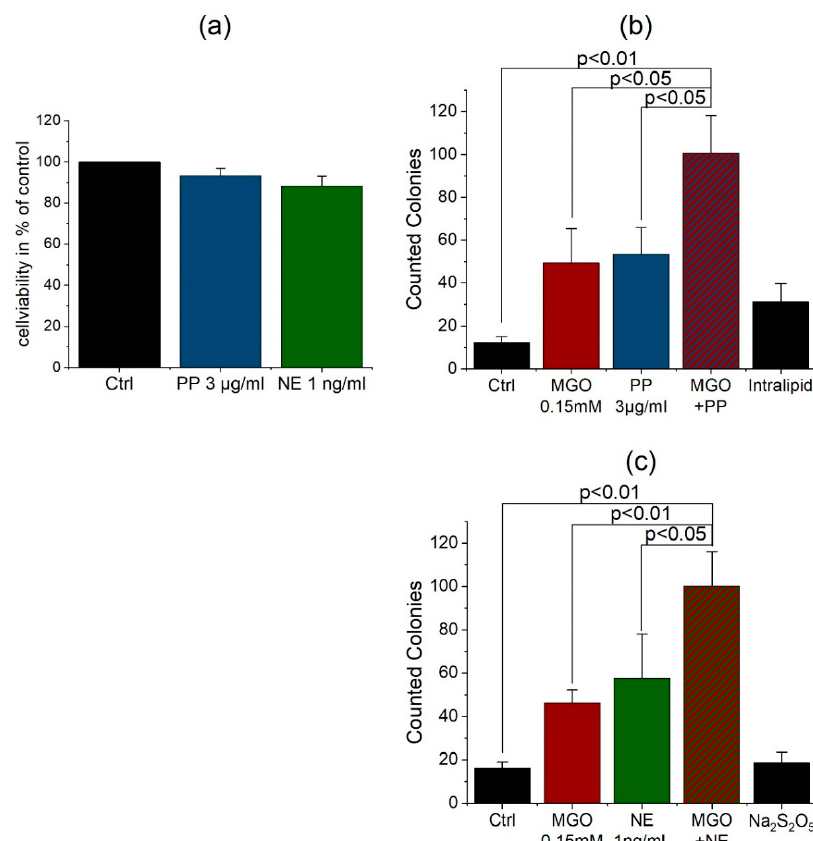
Figure 4. Cell viability of the compounds propofol (PP) and norepinephrine (NE) in endothelial cells ( a ). THBMECs were treated with 3 µg/mL propofol for 3 h and 1 ng/mL norepinephrine for 1 h. MTT assays were performed to analyze the cell viability after treatment. The graph shows the mean + SEM of the cell viability, untreated cells served as control, ( n = 3). Microbial traversal in presence of propofol and norepinephrine with and without MGO treatment. THBMECs were treated with 0.15 mM MGO for 1 h. Afterwards, glycated and non-glycated cells were treated with 3 µ g / mL propofol for 3 h ( b ) or with 1 ng/mL norepinephrine for 1 h ( c ). 450 µL of E.coli suspension (OD 0.5) were put into each upper chamber. Medium from the lower chamber was plated on agar plates after 6 h. The graph shows the mean + SEM of counted colonies, untreated cells and intralipid ( b ) or sodium metabisulfite ( c ) served as control, ( n =